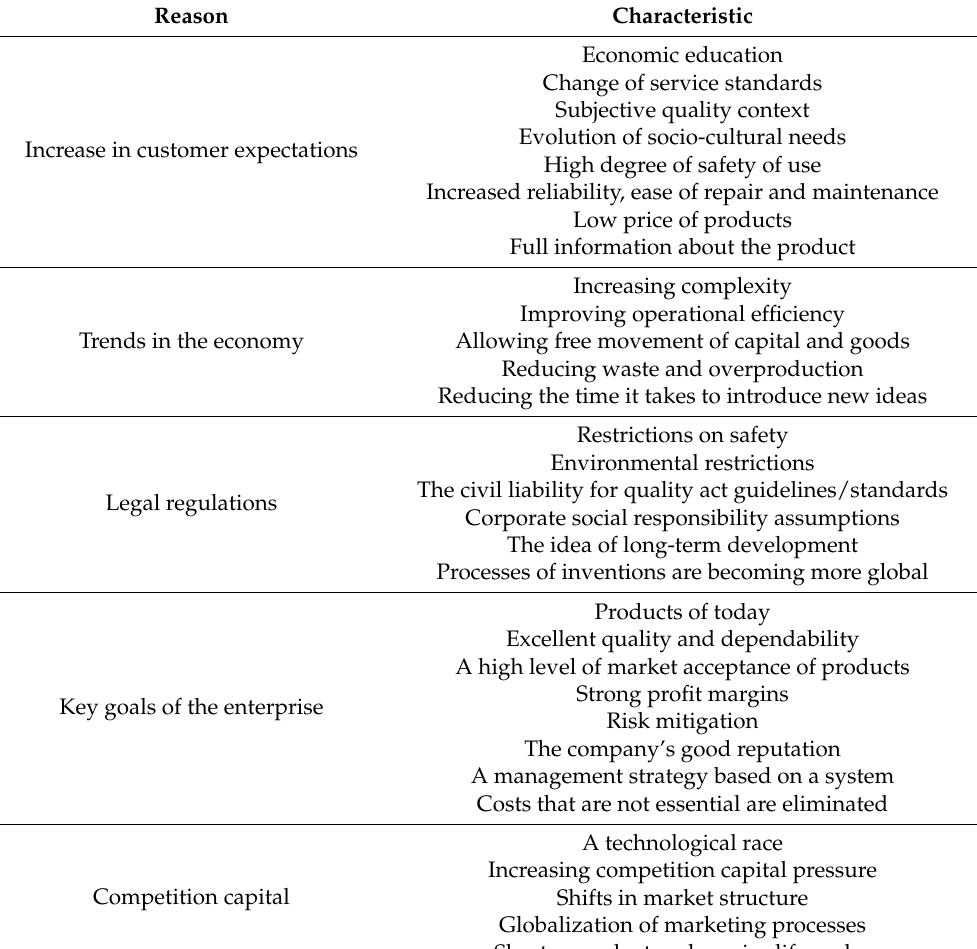
Table 1. The elements that are responsible for the rise in quality